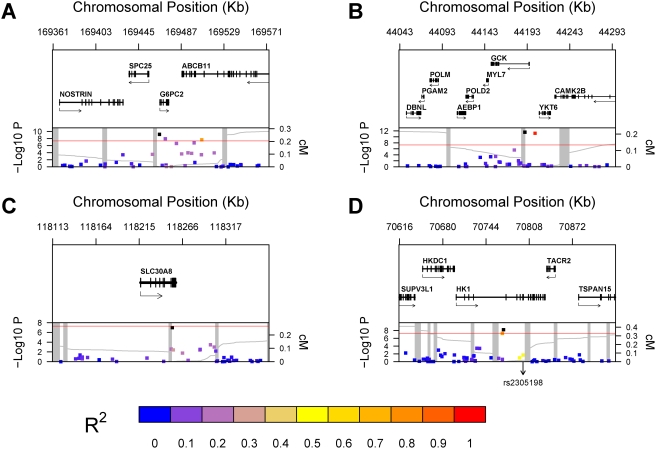
Genetic Context of Significant Associations.Genomic context for each of four loci with significant association with glycated hemoglobin levels. (A) G6PC2 locus (2q24.3); (B) GCK locus (19p13.2); (C) SLC30A8 locus (8q24.11); (D) HK1 locus (10q21.3). Upper panel: Genes from RefSeq release 25. Only one isoform is shown when multiple splicing variants are known. Lower Panel: SNPs are shown according to their physical location and −log10 P-values for association with glycated hemoglobin. At each locus, the SNP with the lowest P-value is represented by a black dot. The color of each other SNP was determined according to its linkage disequilibrium (r2) with the SNP with the lowest P-value, with colors varying from blue (r2 = 0) to red (r2 = 1). In Figure 1-D, the chromosomal position of rs2305198 is shown as this SNP was selected by the model selection algorithm in addition to the SNP with the lowest P-value (see text for details). The red line represents the genome-wide significance threshold of 5×10−8. Also shown is the genetic distance in cM from the lowest P-value SNP (light grey line) along with the position of recombination hotspots (light grey vertical bars). Recombination rates and hotspots are based on HapMap data, as described by McVean et al.[46] and Winckler et al.[47].